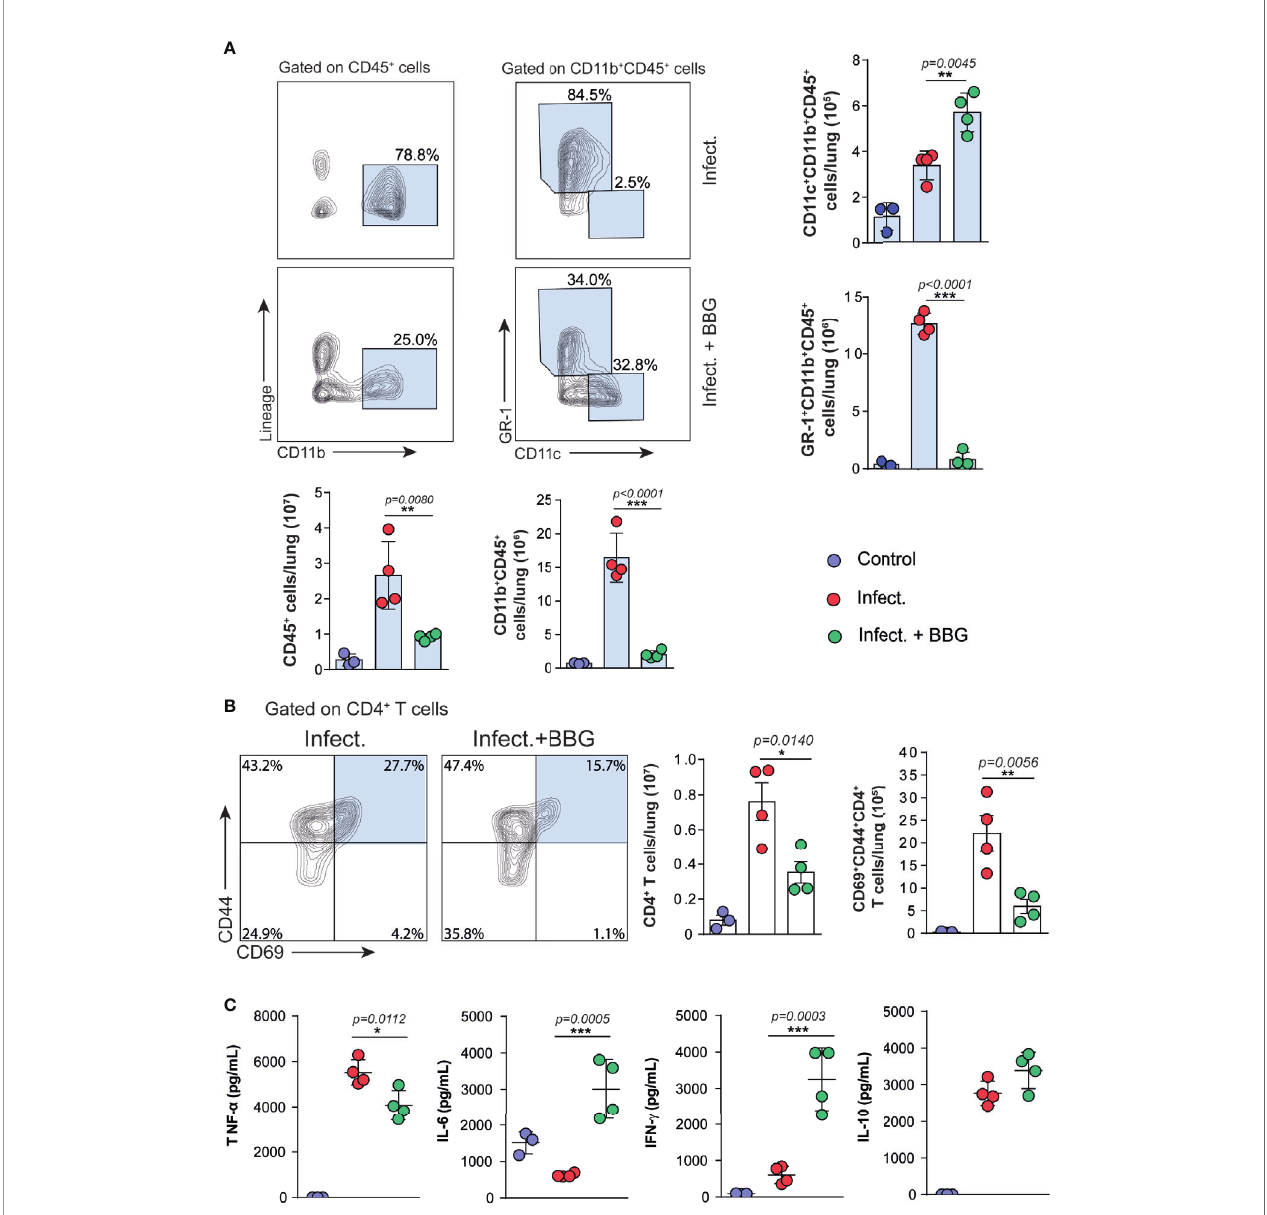
FIGURE 4 | P2X7-directed therapy reduces the pulmonary in fl ammatory response, but increases the population of CD11c + myeloid cells and the production of IFN- g and IL-6 by lung cells. Lung cells from BBG-treated and untreated mice were evaluated at day 28 p.i. with ~100 MP287/03 bacilli. Lung cells from uninfected mice were used as control. (A) Contour-plots show the expression of CD11b vs lineage in CD45 + cells and CD11c vs GR-1 in CD11b + CD45 + cells. Bar graphs show cell numbers per lung. (B) Contour-plots show CD44 and CD69 expression in CD4 + T cells. Bar graphs show cell numbers per lung. (C) Cytokine levels in 48h-culture supernatants of lung cells are shown. Signi fi cant differences were observed between the indicated groups with * p < 0.05, ** p < 0.01 and *** p < 0.001, using One-way ANOVA and Tukey ’ s post hoc tests. The statistical differences between uninfected and infected groups are not shown. Data are representative of two independent experiments with three to four mice in each